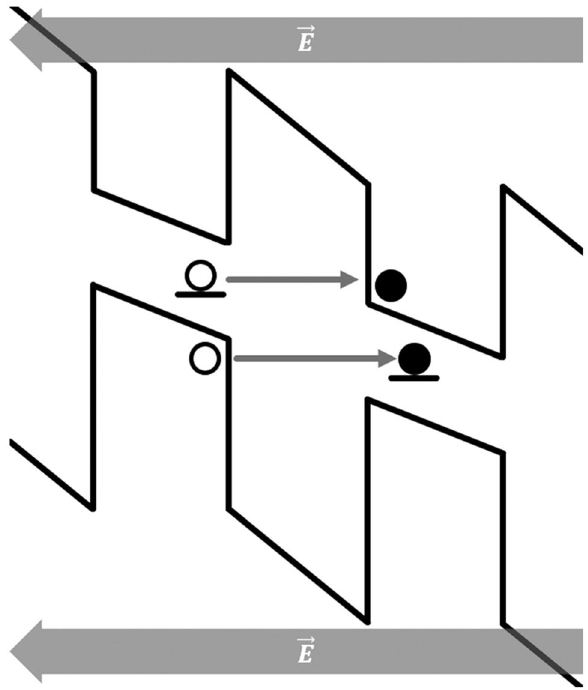
Figure 2. Diagram showing the biased band structure within a section of the superlattice with transitions